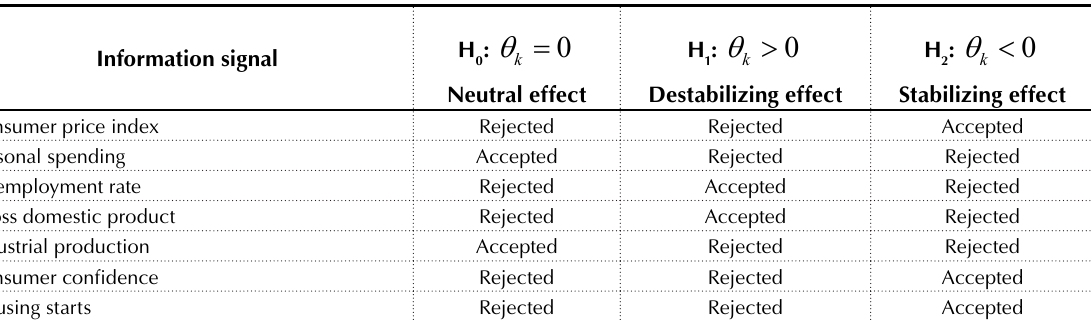
Table 10. The results of testing the hypotheses H component of the “surprise” of non-monetary information signals on stock quotes of enterprises of the economic sector “Financials”